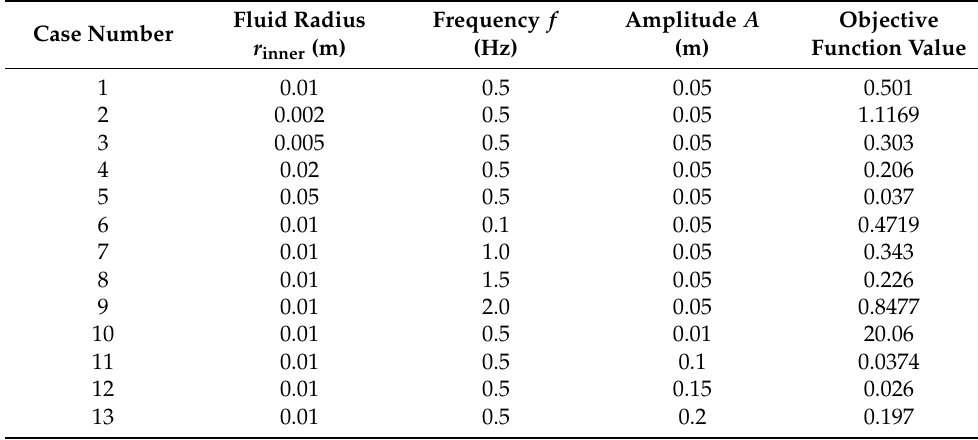
Table 2. Combinations of input variables that were investigated.